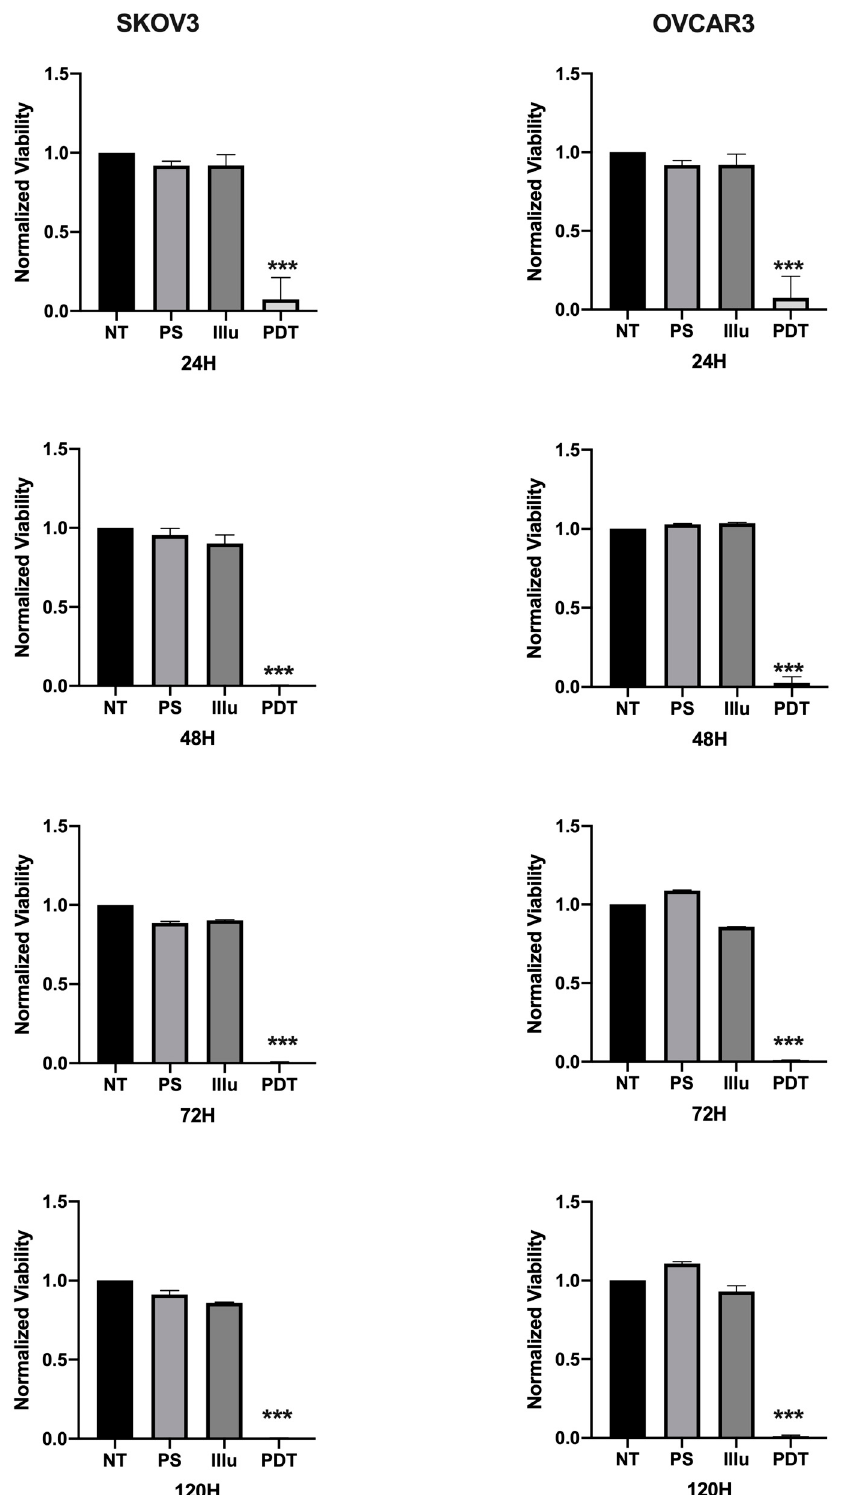
Figure 4. Percentage of Viability for OVCAR3 and SKOV3 at 24 h, 48 h, 72 h, and 120 h post-illumination. NT: non-treated, PS: Photosensitizer only, ill: illumination only, PDT: illumination in the presence of